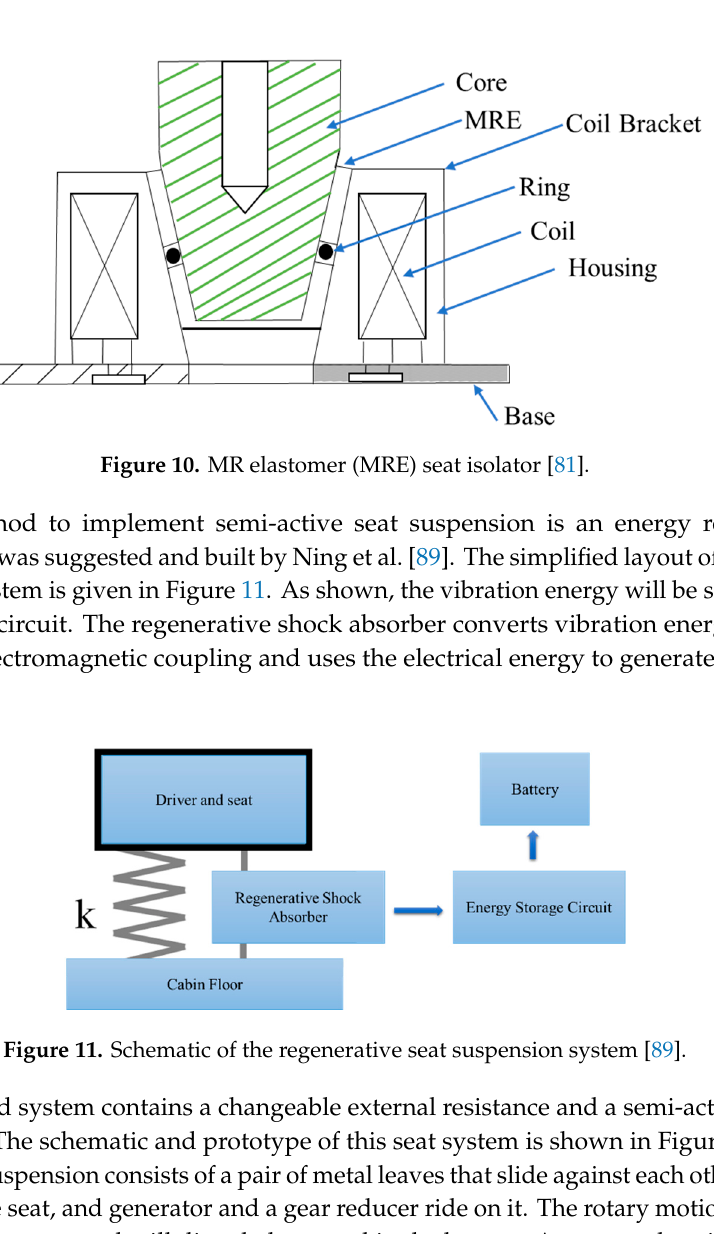
Figure 12. ( A ) Semi-active regenerative seat suspension schematic. ( B ) Seat suspension prototype [89].